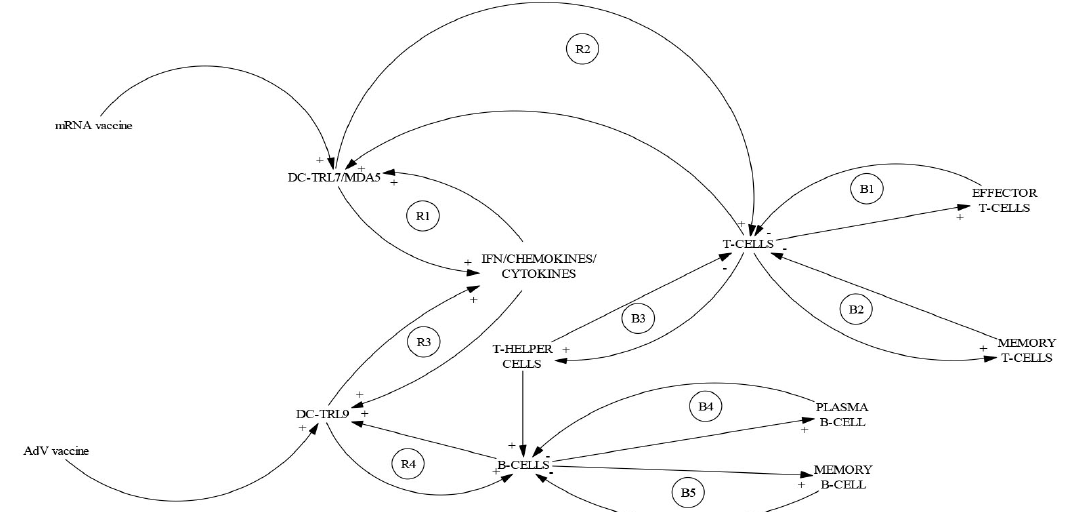
Figure 4. CLD represents the immune data compression generated by COVID-19 effective vaccines. Immune data compression can be represented by the very effective modes of action of COVID-19 vaccines. The CLD graph was taken from Teijaro and Farber [18], and illustrates how vaccines from different technological platforms induce a complex set of signaling pathways involving the action, initially, of reinforcing sub-cycles (R1–R4) and after, the activation of balancing sub-cycles (B1–B5) leading to the establishment of the epitome of data compression: the B and T memory cells